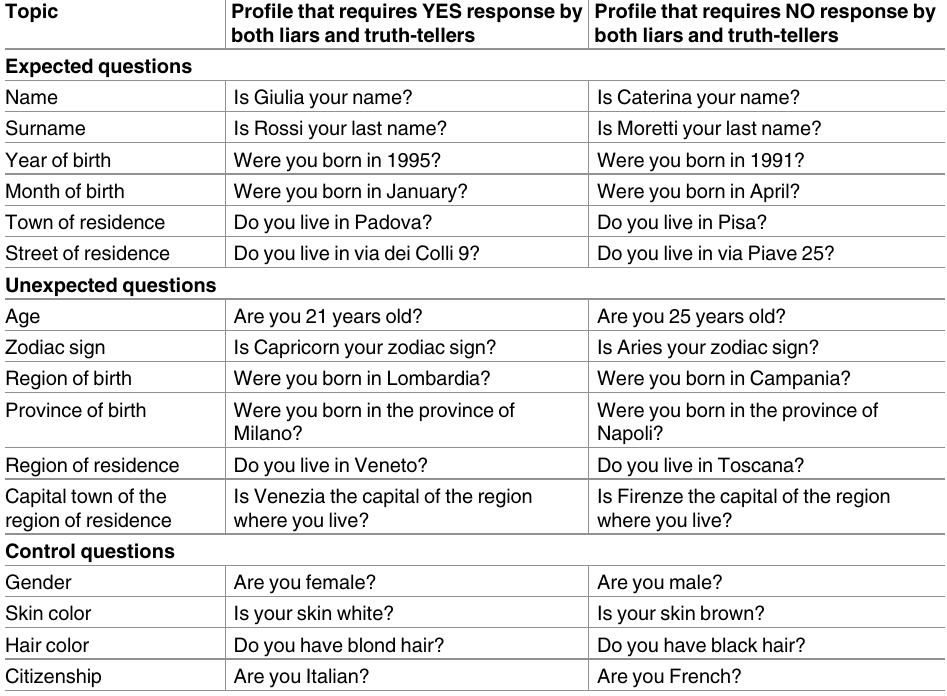
Table 1. Examples of expected questions, unexpected questions and control.